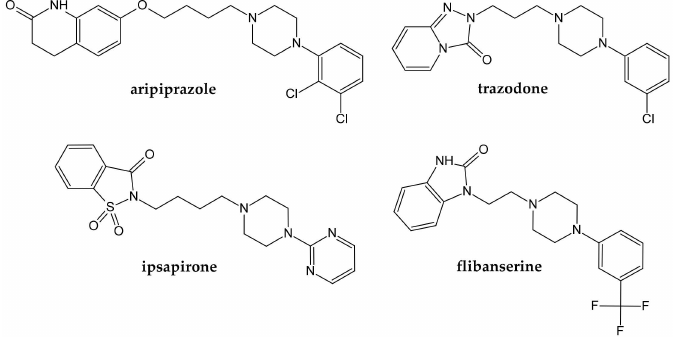
Figure 1. Examples of long-chain arylpiperazines: aripiprazole, trazodone, ipsapirone, flibanserine. Aripiprazole belongs to the group of atypical antipsychotic drugs. It is a partial agonist of dopamine D 2 and serotonin 5-HT 1A receptors and an antagonist of dopamine D 3 and serotonin 5-HT 2A receptors, and is used in the treatment of schizophrenia and bipolar disorder. Trazodone acts as an antagonist of 5-HT 2A serotonin receptors and as a serotonin reuptake inhibitor (SARI). It is a well-known antidepressant and serotonin reuptake inhibitor. Ipsapirone exhibits activity as a selective partial 5-HT 1A and D 2 agonist and has antidepressant and anxiolytic effects. Another interesting drug from the LCAP group is flibanserin. It acts as an agonist of postsynaptic 5-HT 1A receptors and antagonist to other serotoninergic receptors (5-HT 2A and 5-HT 2B as well as 5-HT 2C ). However,